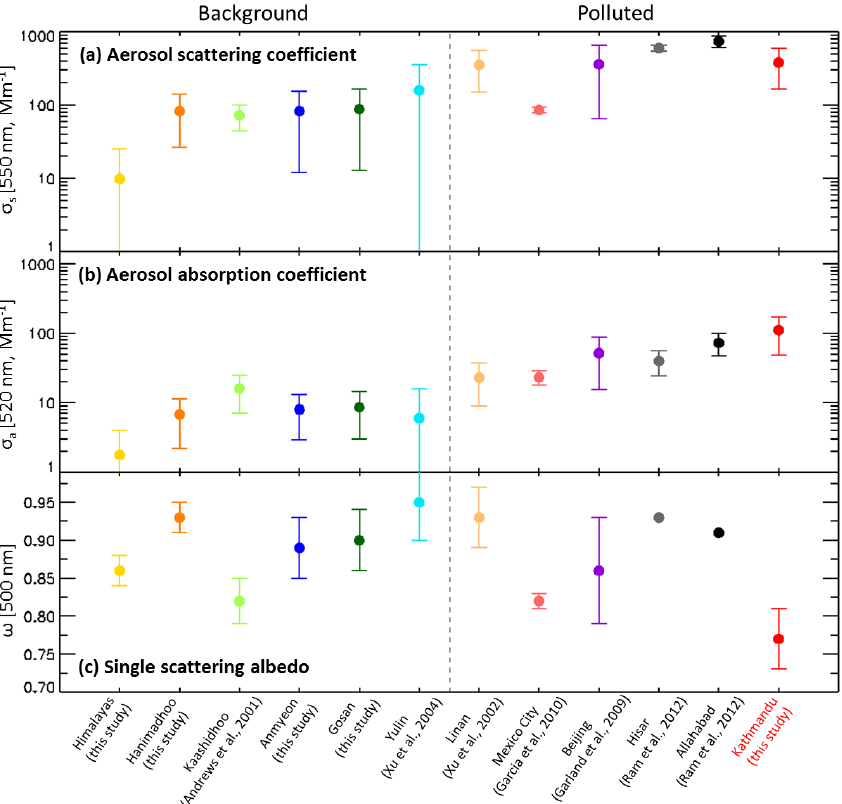
Figure 4. Comparison of the (a) aerosol scattering coefficient, (b) aerosol absorption coefficient, and (c) single scattering albedo measured at several locations worldwide, segregated by the background and polluted area. Note that the scale of the scattering and absorption coefficients is logarithmic